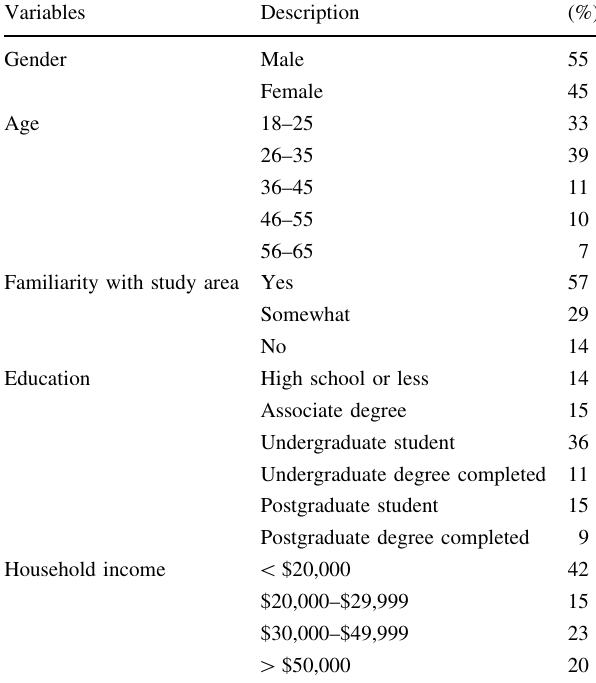
Table 1 Socio-demographic characteristics of the